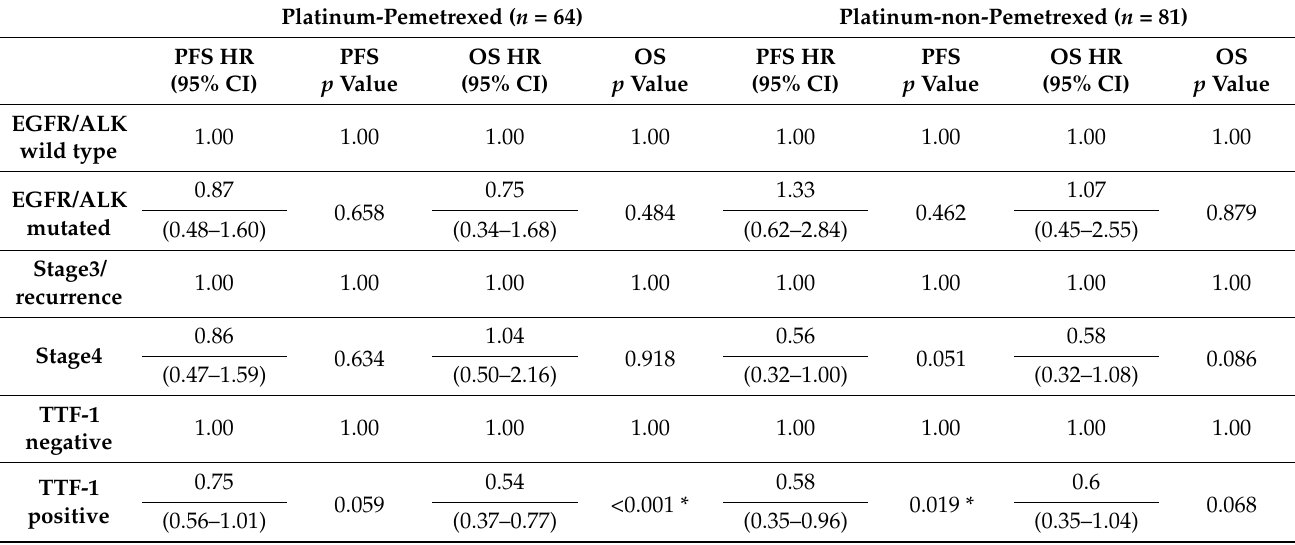
Table 2. Multivariable analysis of PFS and OS in regimen with and without